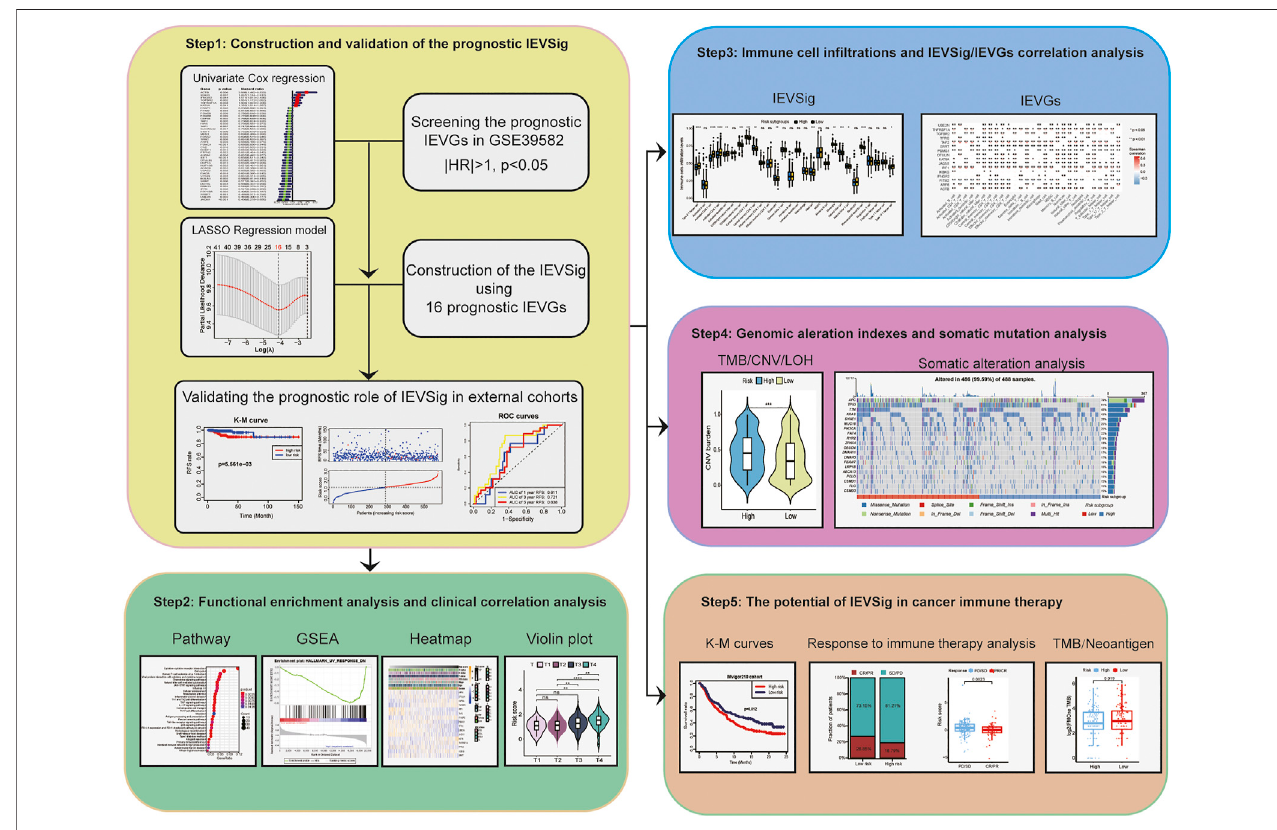
FIGURE 1 | Work fl ow chart of our